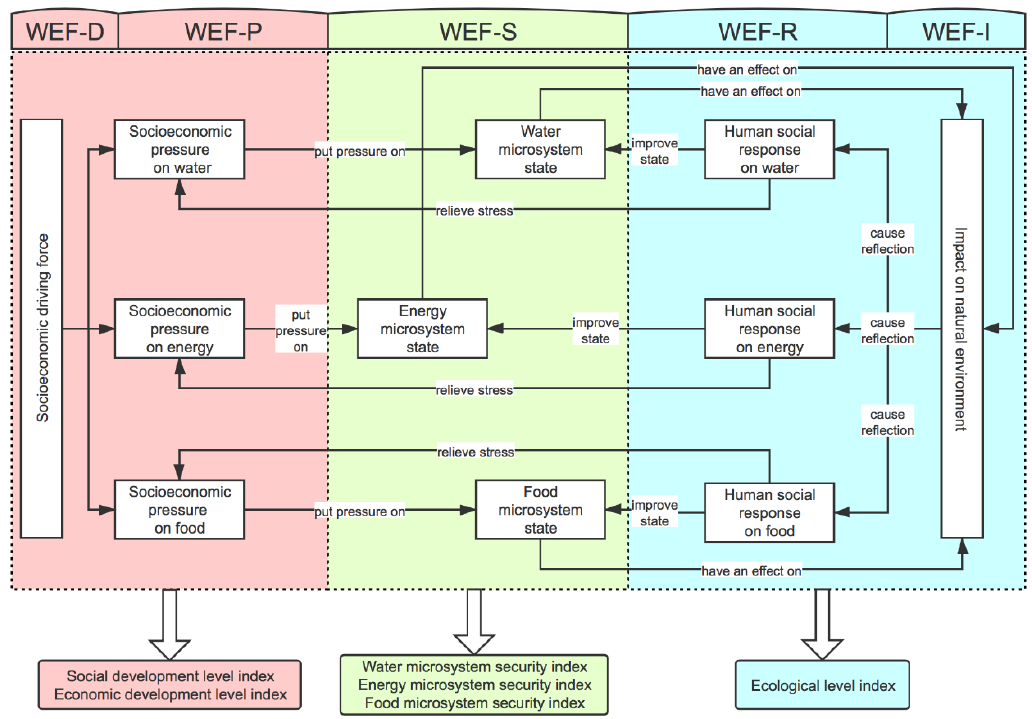
Figure 3. Water-energy-food driving force-pressure-state-influence-response (WEF-DPSIR) structural model. Note: WEF-D = socioeconomic driving force subsystem, WEF-P = socioeconomic pressure subsystem, WEF-S = microsystem situation subsystem, WEF-I = environmental impact subsystem, WEF-R = human social response subsystem .